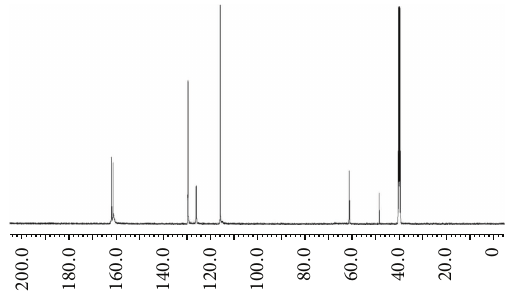
Figure 1: 1 H NMR spectra of EAB.